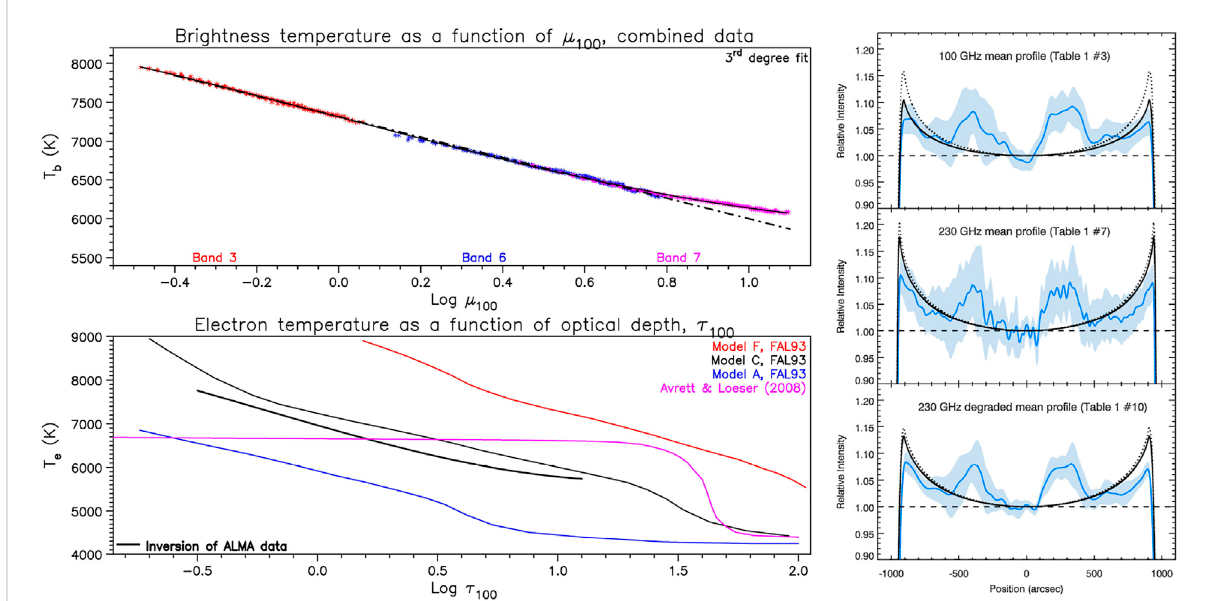
FIGURE 9 Atmospheric modeling from ALMA CLV data Left, top: Combined CLV curve, T e (log τ 100 ), from ALMA Band 3, Band 6 and Band 7 observations obtainedinJanuary2020,adaptedfromAlissandrakisetal.(2022).Thesolidlineshowsathirddegree fi tandthedash-dottedlineshowsalinear fi tup to log μ 100 = 0.8. Reproduced with permission ⓒ ESO. Left, bottom: The electron temperature as a function of optical depth (thick black line) obtained from the inversion of the CLV curve. Also shown are the predictions of atmospheric models discussed in the text. Adapted from Alissandrakis et al. (2022). Right: Comparison between observed CLV (blue curves) and the predictions of models C (dotted lines) and SSC (continuous black lines). The dashed line represents the quiet Sun. From Selhorst et al., 2019 ⓒ AAS, reproduced with